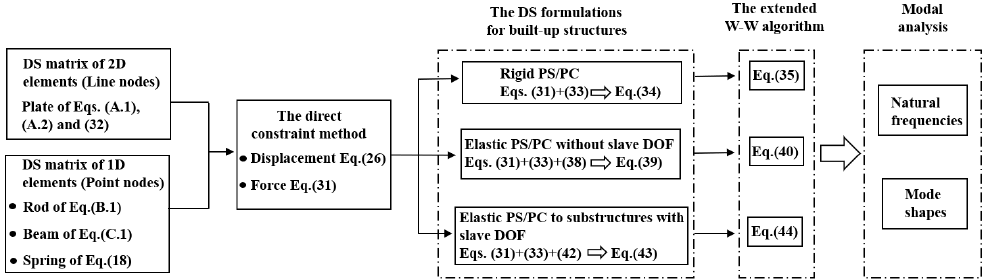
Figure 9. Flow chart for the modal solution procedure by the proposed dynamic stiffness formulation as well as the associated Wittrick-Williams algorithm for built-up